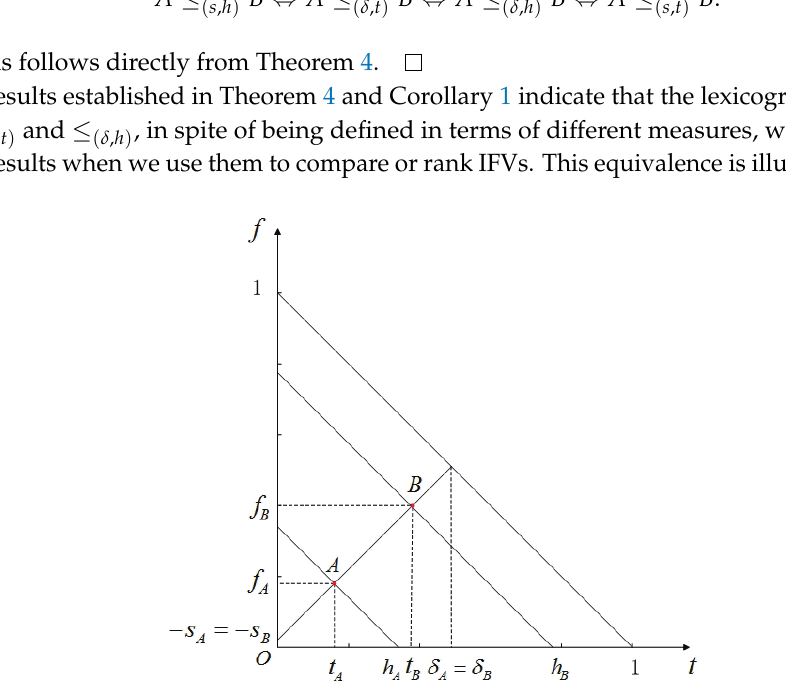
Figure 1. The equivalence of the orders ≤ ( s , t ) , ≤ ( s , h ) , ≤ ( δ , t ) and ≤ ( δ , h )